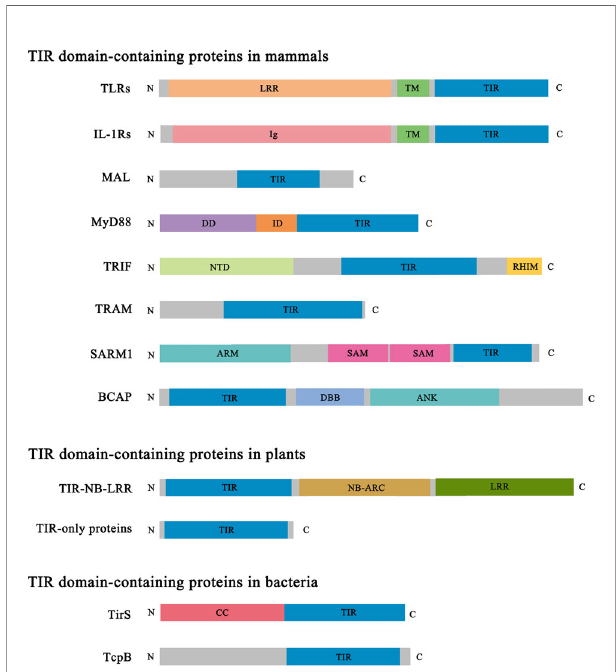
FIGURE 2 | Domain architecture of representative TIR domain-containing proteins. TIR, Toll/interleukin-1 receptor/resistance protein; LRR, leucine-rich repeat; TM, transmembrane; Ig, immunoglobulin; DD, death domain; ID, intermediate domain; NTD, N-terminal domain; RHIM, RIP (receptor- interacting protein) homotypic interaction motif; ARM, armadillo-repeat motif; SAM, sterile alpha motif; DBB, Dof (Drosophila downstream of fi broblast growth factor receptor)/BCAP/BANK (B cell scaffold protein with ankyrin repeats); ANK, ankyrin repeat; NB-ARC, nucleotide-binding adaptor shared by APAF-1 (apoptotic protease-activating factor 1), R proteins and CED-4 (cell death protein 4); CC, coiled